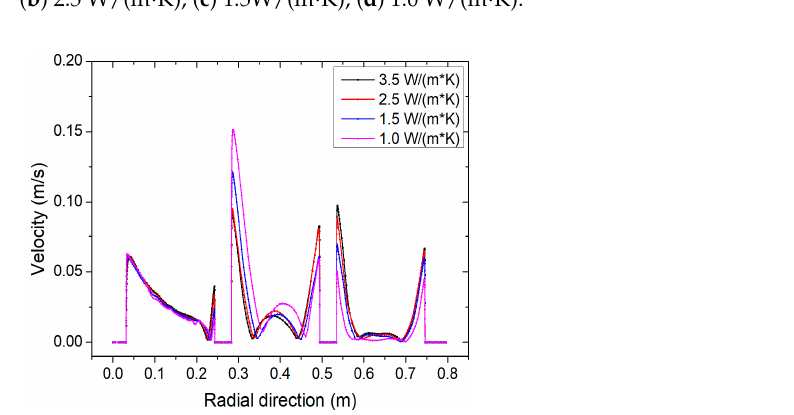
Figure 11. Contour of velocity magnitude for different thermal conductivity of SiC ( a ) 3.5 W/(m ∙ K); ( b ) 2.5 W/(m ∙ K); ( c ) 1.5W/(m ∙ K); ( d ) 1.0 W/(m ∙ K).